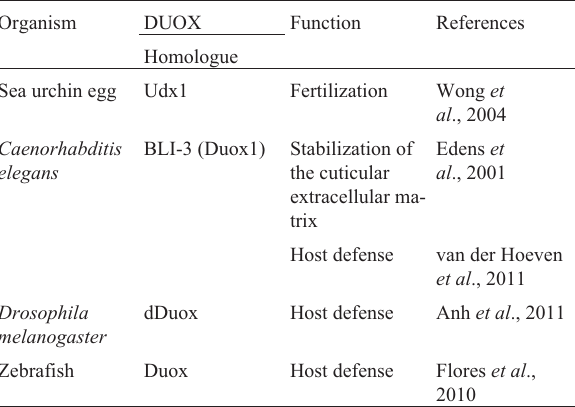
Table 2 - Physiological functions of DUOXS in